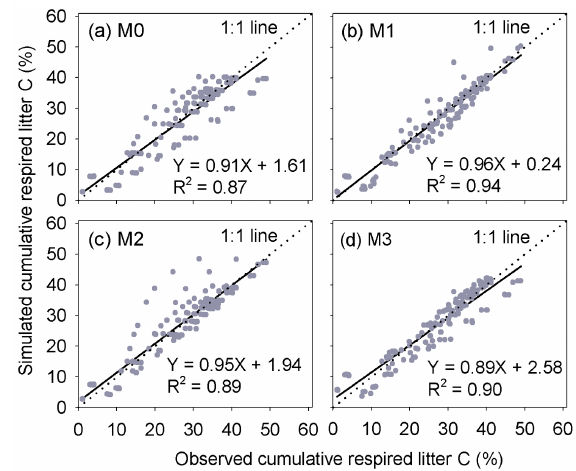
Figure 3. Comparison of the predicted cumulative respired litter C to observed values at different times during the litter decomposition process. Each dot denotes an observation of cumulative respired lit- ter C on a certain day. In total, there are 149 points. M0–M3 are the four versions of litter decay models tested in this study (Table 1).